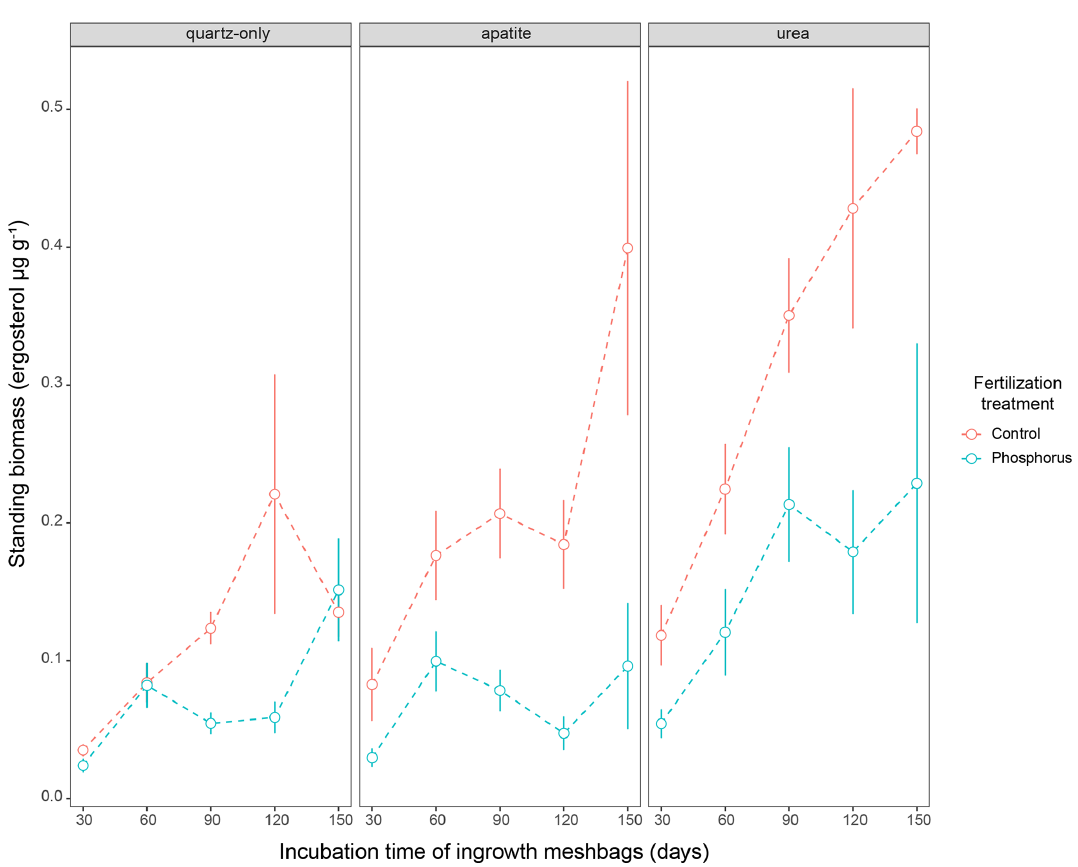
Figure 3. Standing EMF biomass in the three mesh-bag amendments (quartz-only, apatite and urea) and in the control plots (red symbols) as well as the P-fertilized plots (blue symbols) and control plots during different incubation times (30, 60, 90, 120 and 150d). The error bars represent the standard error of the mean. Table 1. Mean of the EMF production in different treatments ( P k ) estimated by Model 1. The highest density intervals (HDIs; Kruschke and Liddell, 2018) represent the boundaries of each estimate at different degrees of